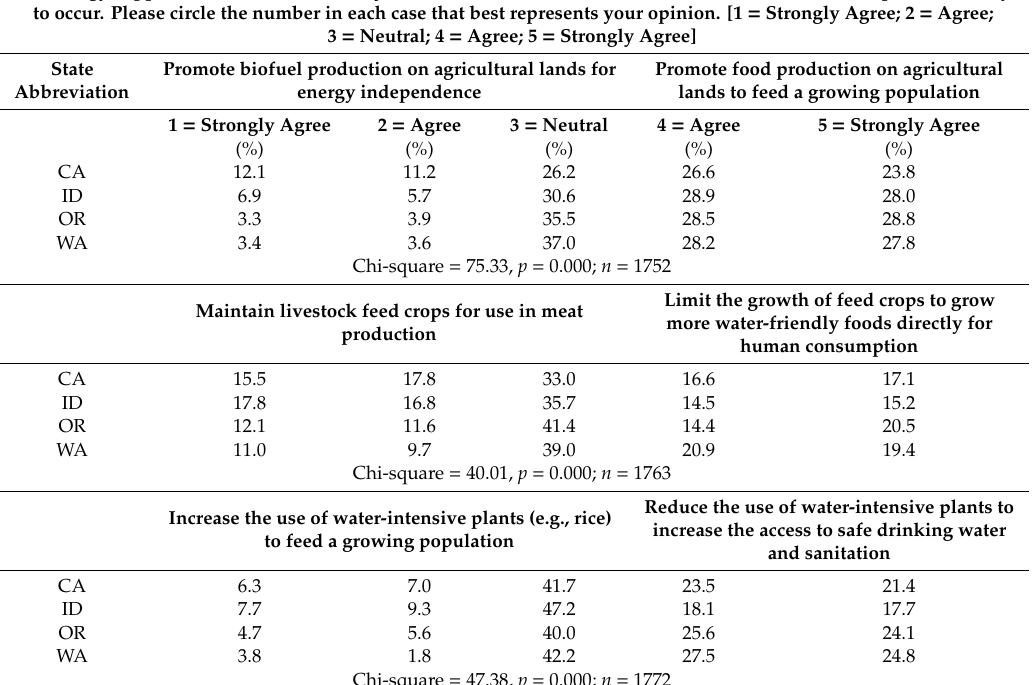
Table 2. Food, energy, and water policy tradeo ff